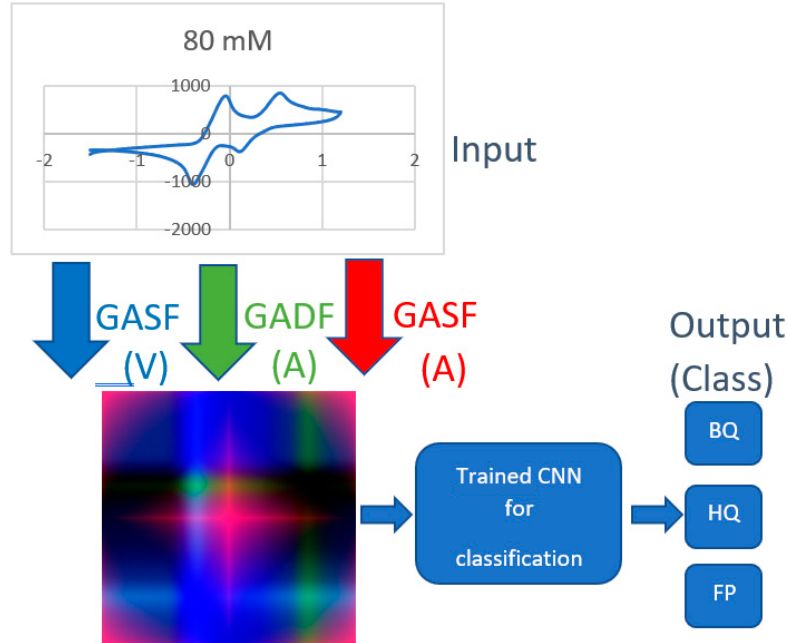
Figure 12. A global overview of the entire workflow of the proposed